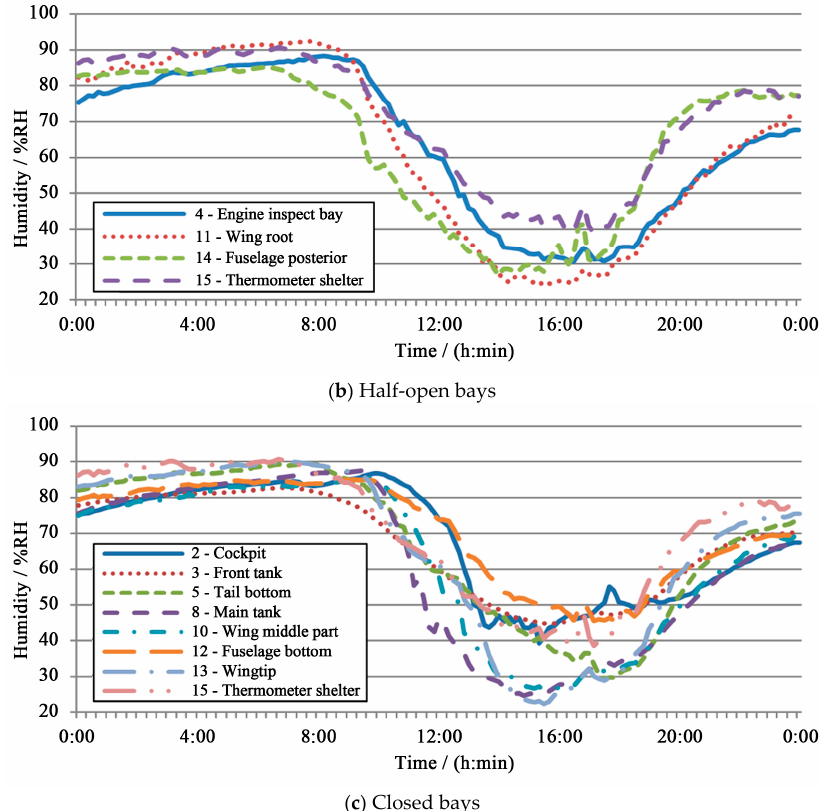
Figure 2. Humidity variation curves on 31 July 2013.